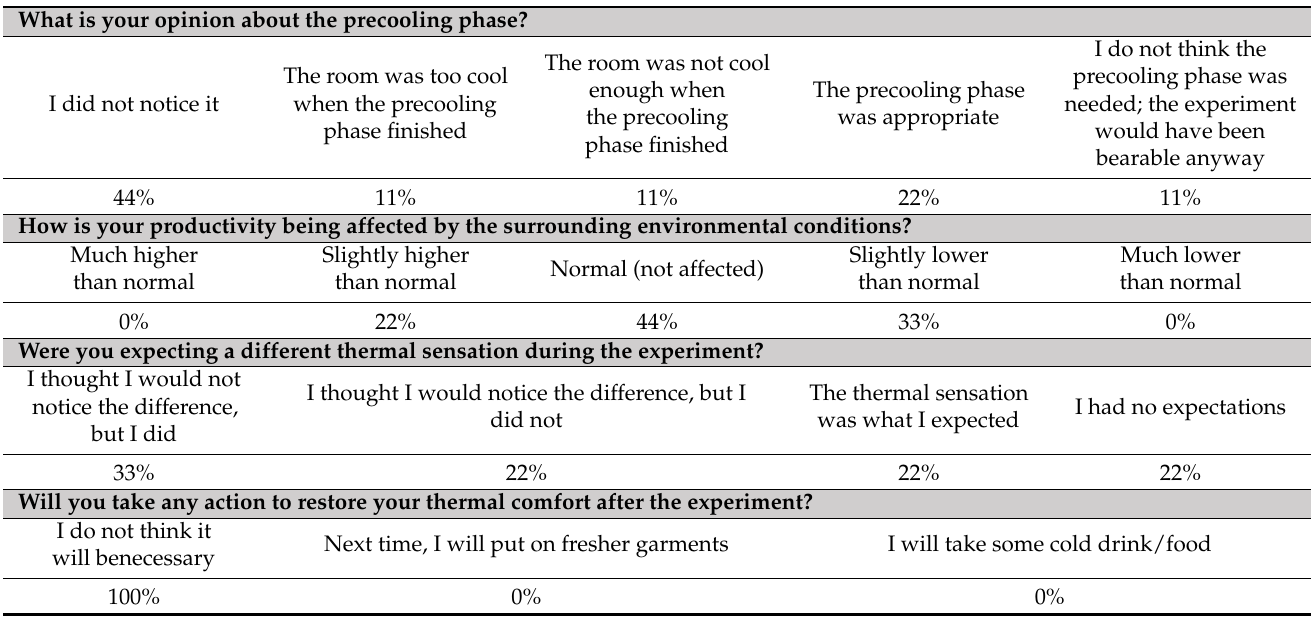
Table 7. Occupants’ answers about the general acceptance of the